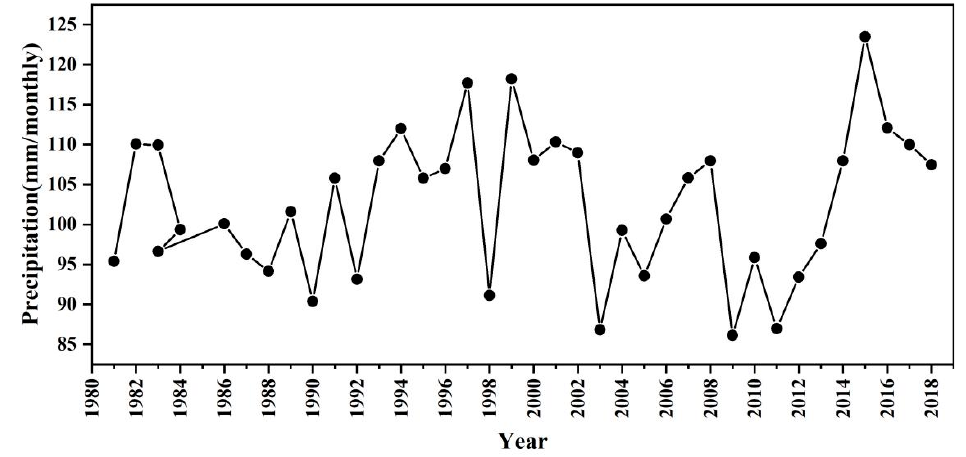
Figure 2 . Average precipitation from 1981 to 2019.